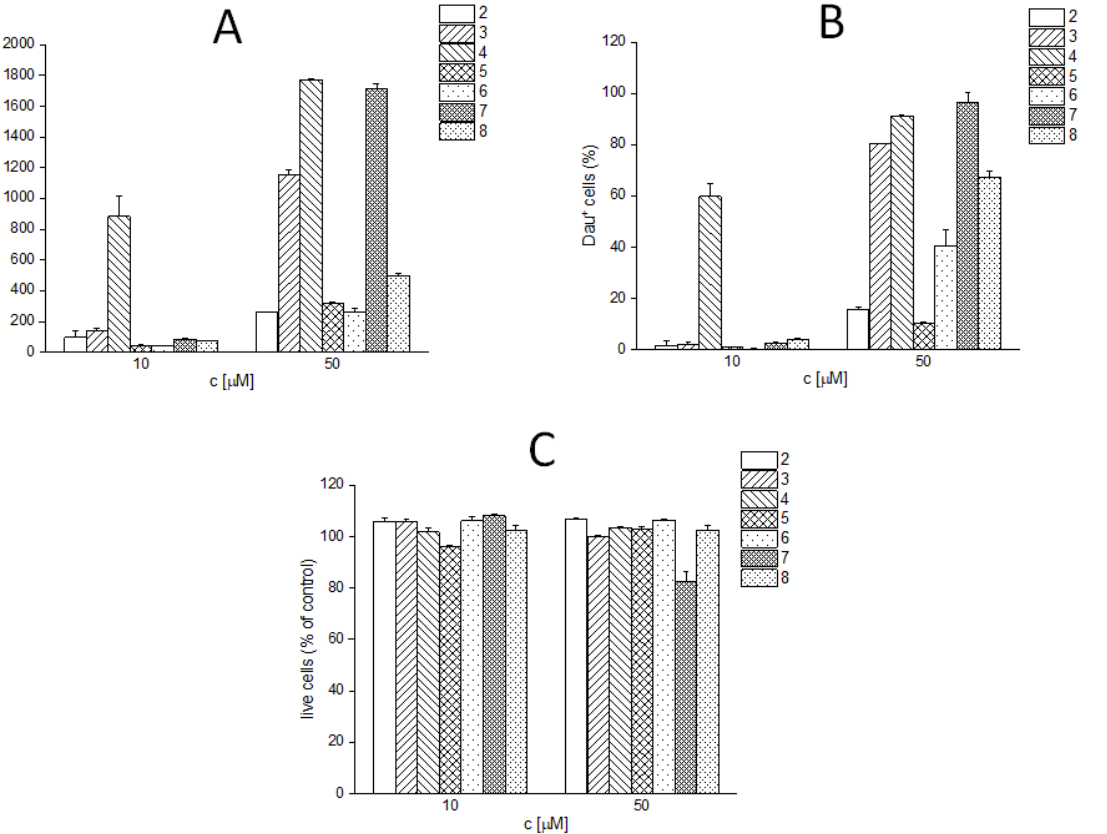
Figure 2. In vitro cellular uptake of Angiopep-2–daunomycin conjugates at 10 and 50 µ M. ( A ) fluorescence mean; ( B ) percentage of the Dau-positive live cells (cells showing fluorescence intensities above the highest fluorescence intensity value of the untreated control cells were considered as Dau+); ( C ) live cells in the percentage of untreated control.